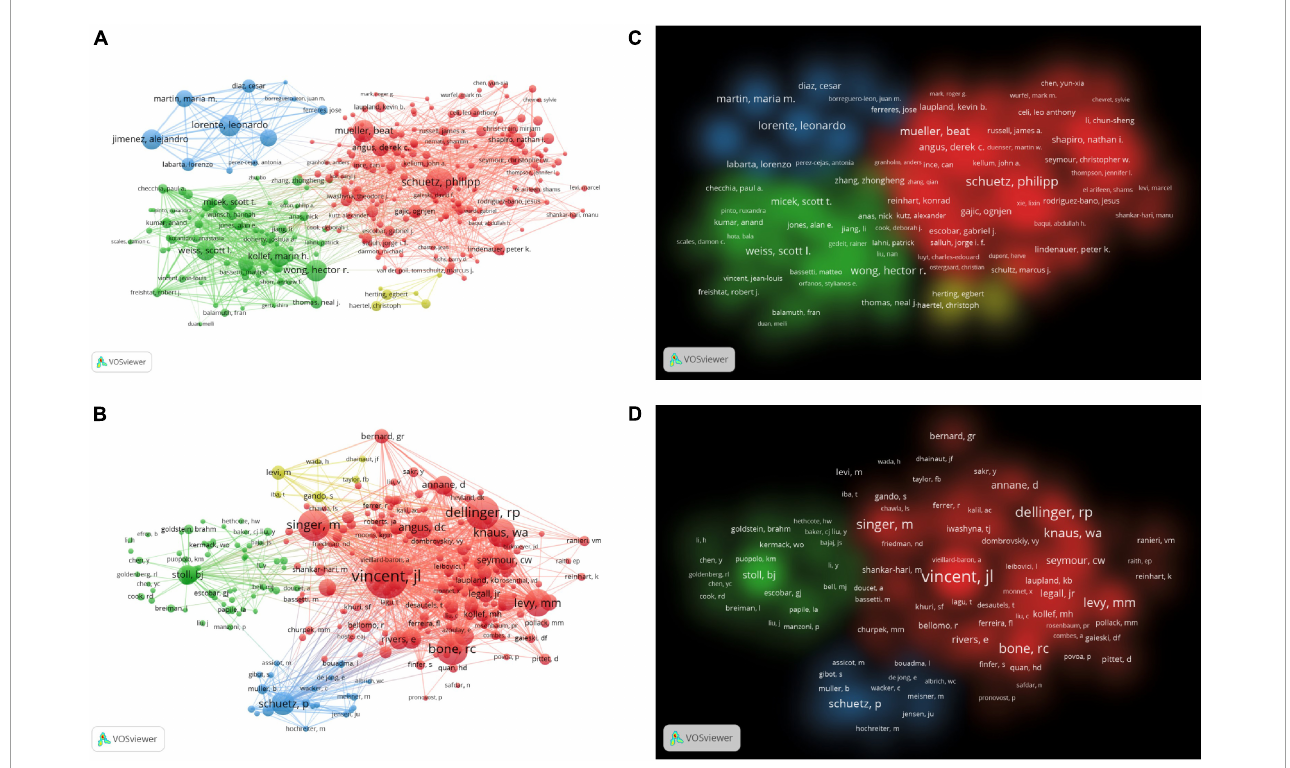
FIGURE4 (A) The network visualization map of co-authorship. (B) The density visualization map of co-authorship. (C) The citation network visualization map of cited authors. (D) The citation density visualization map of cited authors.